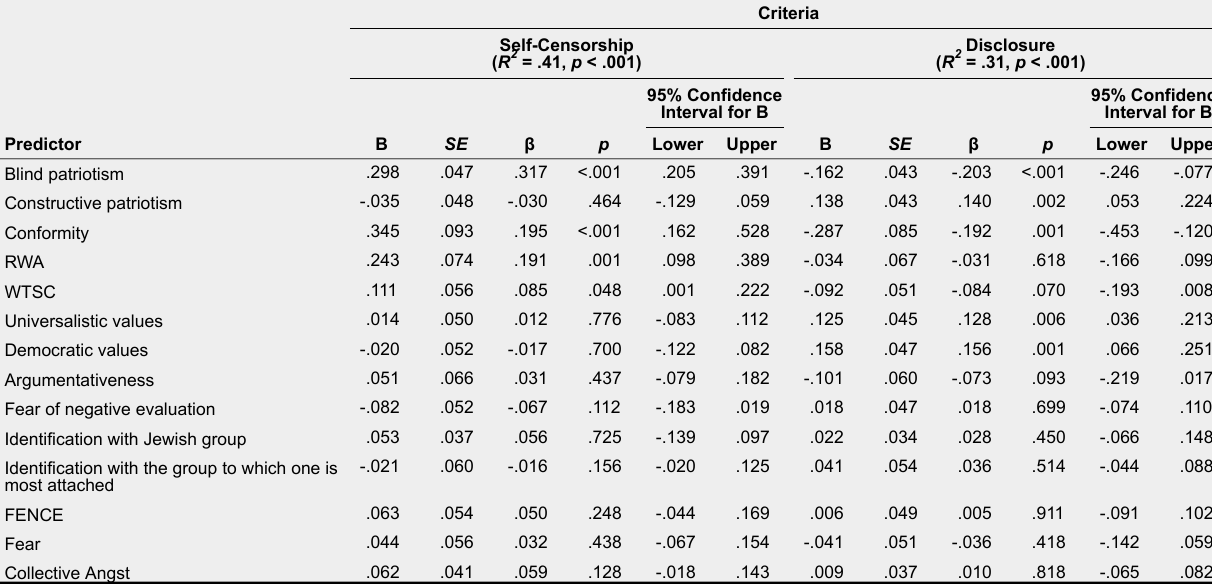
Regression Analyses Predicting the SCO Factors by Other Measures at Stage 1